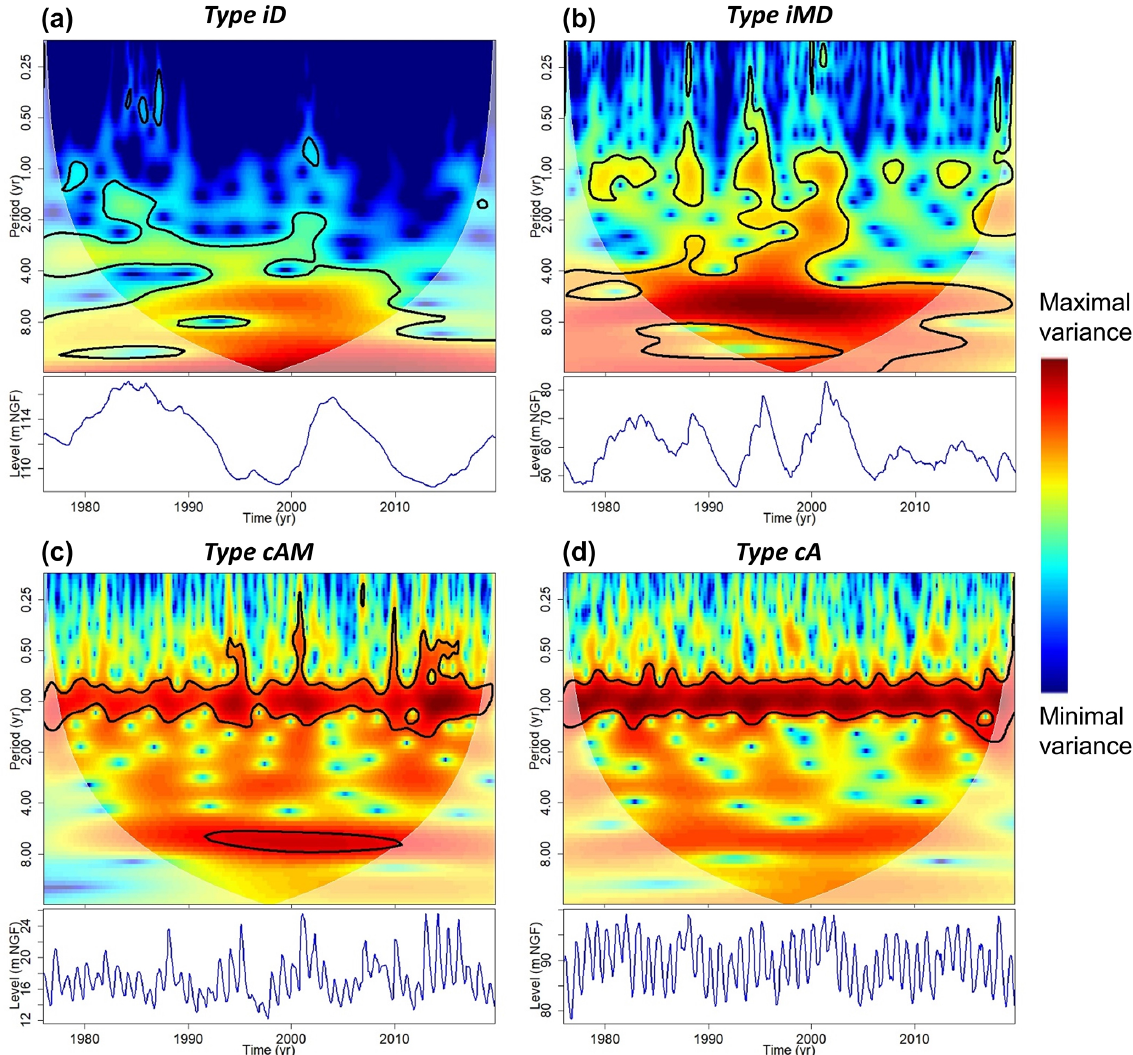
Figure 6. Time series (c, d) and wavelet spectra (a, b) of a typical time series representing each major groundwater level variation type. For type iD, this is the time series of the Thionville borehole (Beauce limestones – entity H); for type iMD, the Blacqueville borehole (chalk of Normandy – entity B); for type cAM, the Pihen-Lès-Guînes borehole (chalk of Artois–Picardy – entity C); and for type cA, the Grandes- Loges borehole (chalk of Champagne – entity D). The contour lines express the statistically significant regions of the spectrum at a confidence level of 95% (Monte Carlo test). The white transparent line corresponds to the cone of influence where the variance is underestimated due to edge